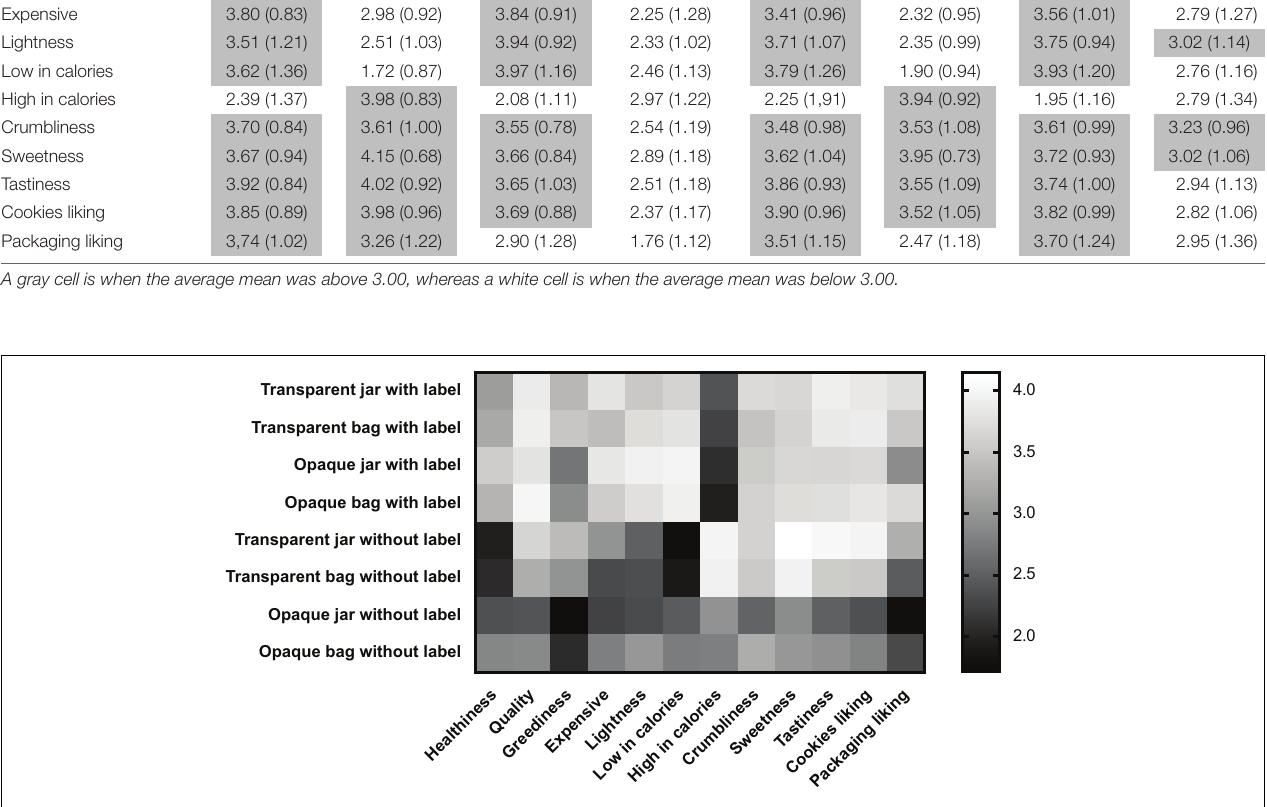
FIGURE 2 | Grayscale heat map representing the mean values of each dependent variables ( X -axis) across the different experimental conditions ( Y -axis). The lower mean values are being represented with the darkest colors, and